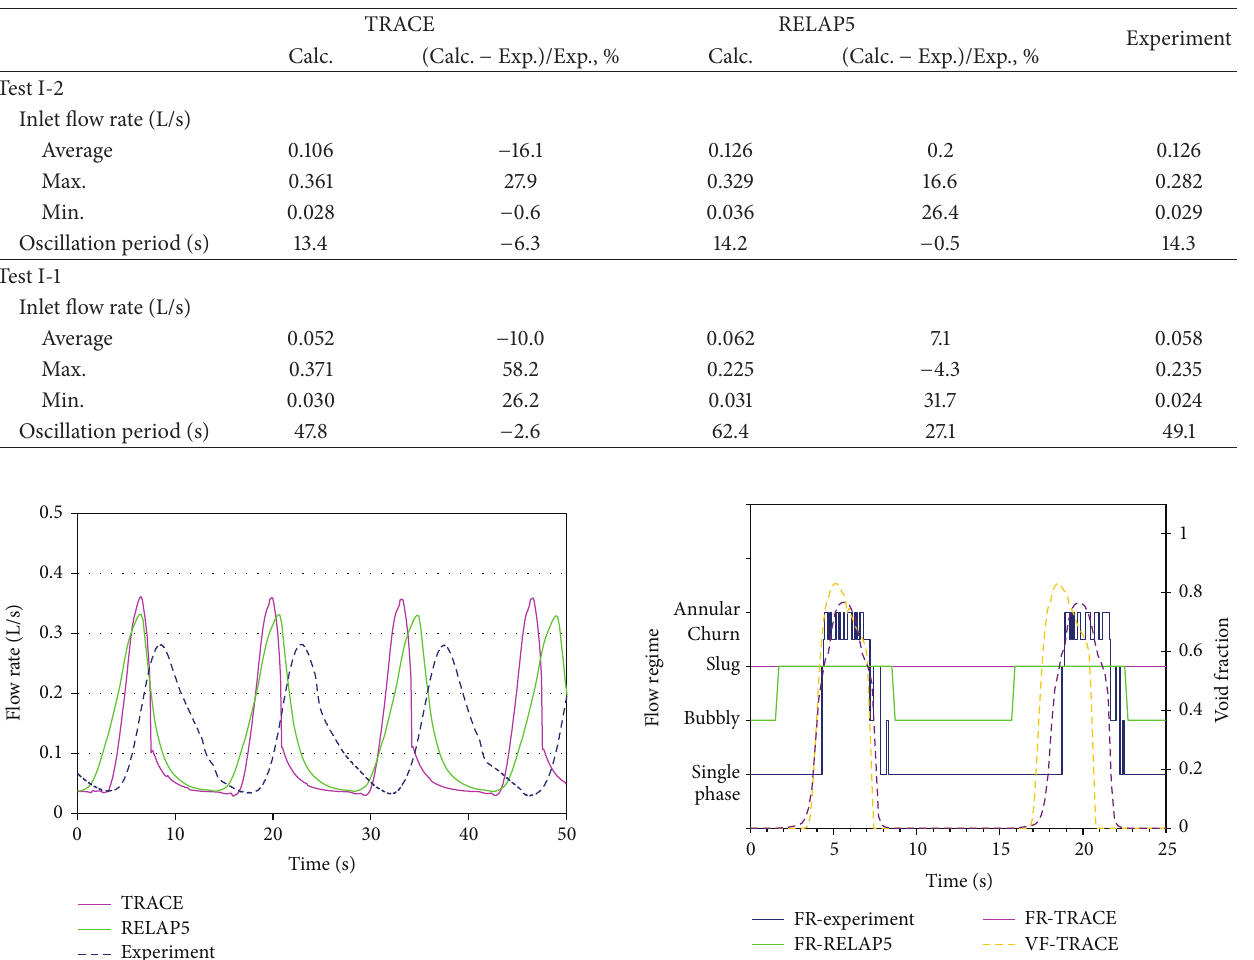
Table 5: Calculated inlet flow rate, oscillation period, and errors normalized to the experiment, tests I-2 and I-1.